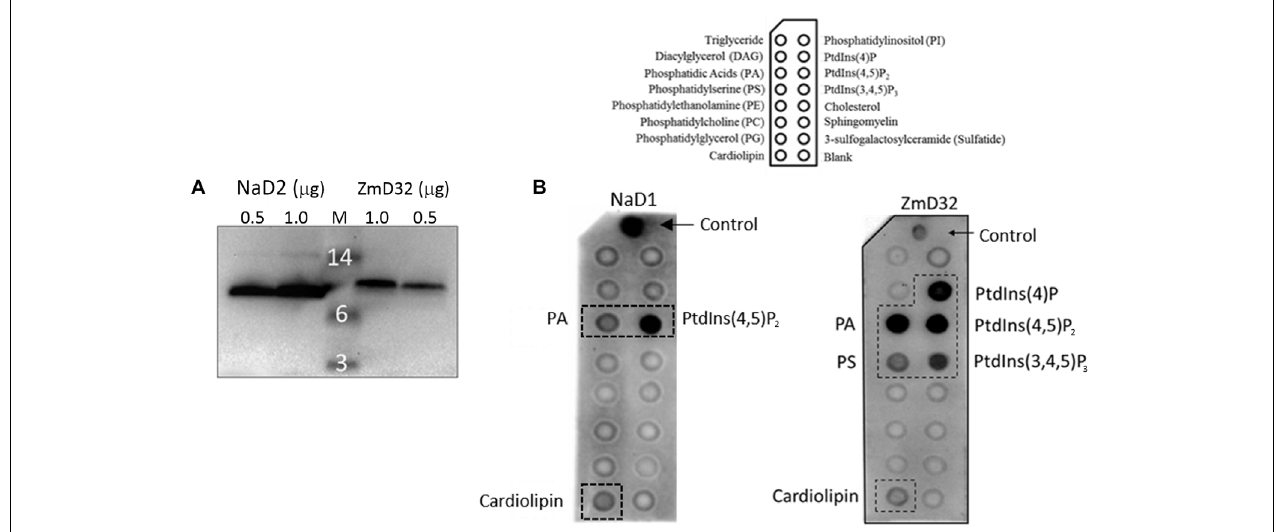
FIGURE 7 | Binding of ZmD32 to lipids immobilized on a membrane lipid strip. (A) α -NaD2 polyclonal antibodies detect ZmD32 on a Western blot. (B) Membrane lipid strips probed with NaD1 or ZmD32 followed by α -NaD1 or α -NaD2, respectively. ZmD32 bound to a number of phospholipids including phosphatidylinositol